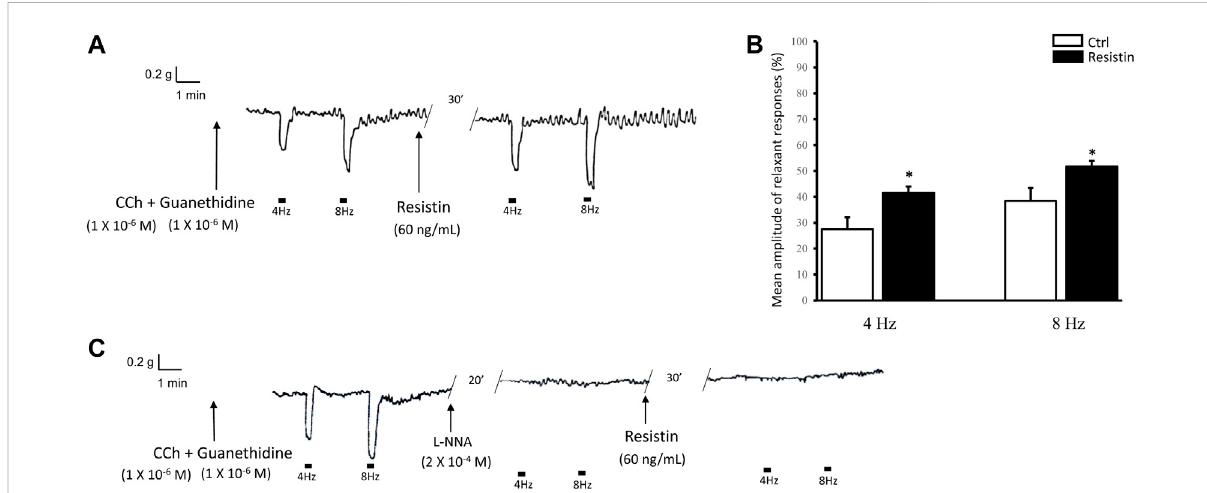
FIGURE 3 In fl uence of resistin on the neurally-evoked relaxant responses and its lack of effects in the presence of L-NNA. (A,B) : representative trace showing that theEFS-evoked relaxant responses at4and 8 Hzstimulationfrequency[ (A) ,left handtrace]are increased in amplitude inthepresence of60 ng/mlresistin(righthandtrace).Barchart (B) oftheeffectsofresistinonthemeanamplitudeoftheEFS-inducedrelaxantresponses.Amplitude values refer to the maximal peak obtained during the stimulation period and represent percentage decreases relative to the muscular tension induced by CCh (1 × 10 − 6 M), taken as 100%. All values are means ± SEM of 8 strips (from 4 mice). * p < 0.05 vs Ctrl (Student ’ s t-test). (C) : Representative tracing showing that the EFS-evoked inhibitory responses at 4 and 8 Hz stimulation frequency (left hand trace) are abolished by 2 × 10 − 4 M L-NNA (middle trace) and the subsequent addition of resistin (60 ng/ml) to the bath medium has no longer effects (right hand trace) on the neurally-evoked relaxant responses. Note the absence of responses to EFS at 4 and 8 Hz stimulation frequency in the presence of either L-NNA or L-NNA +